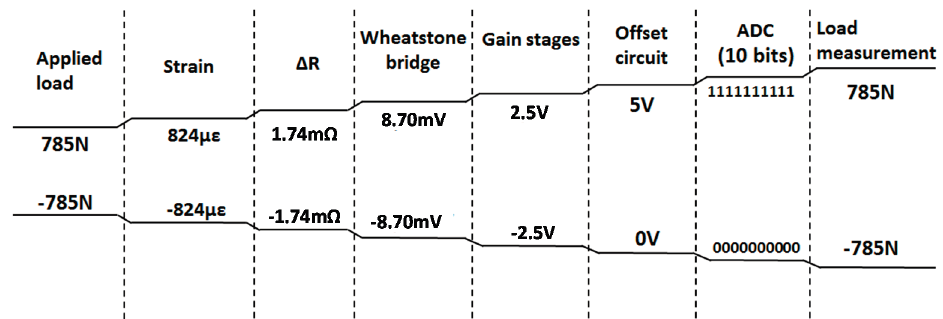
Figure 7. Channel 1’s proposed measurement